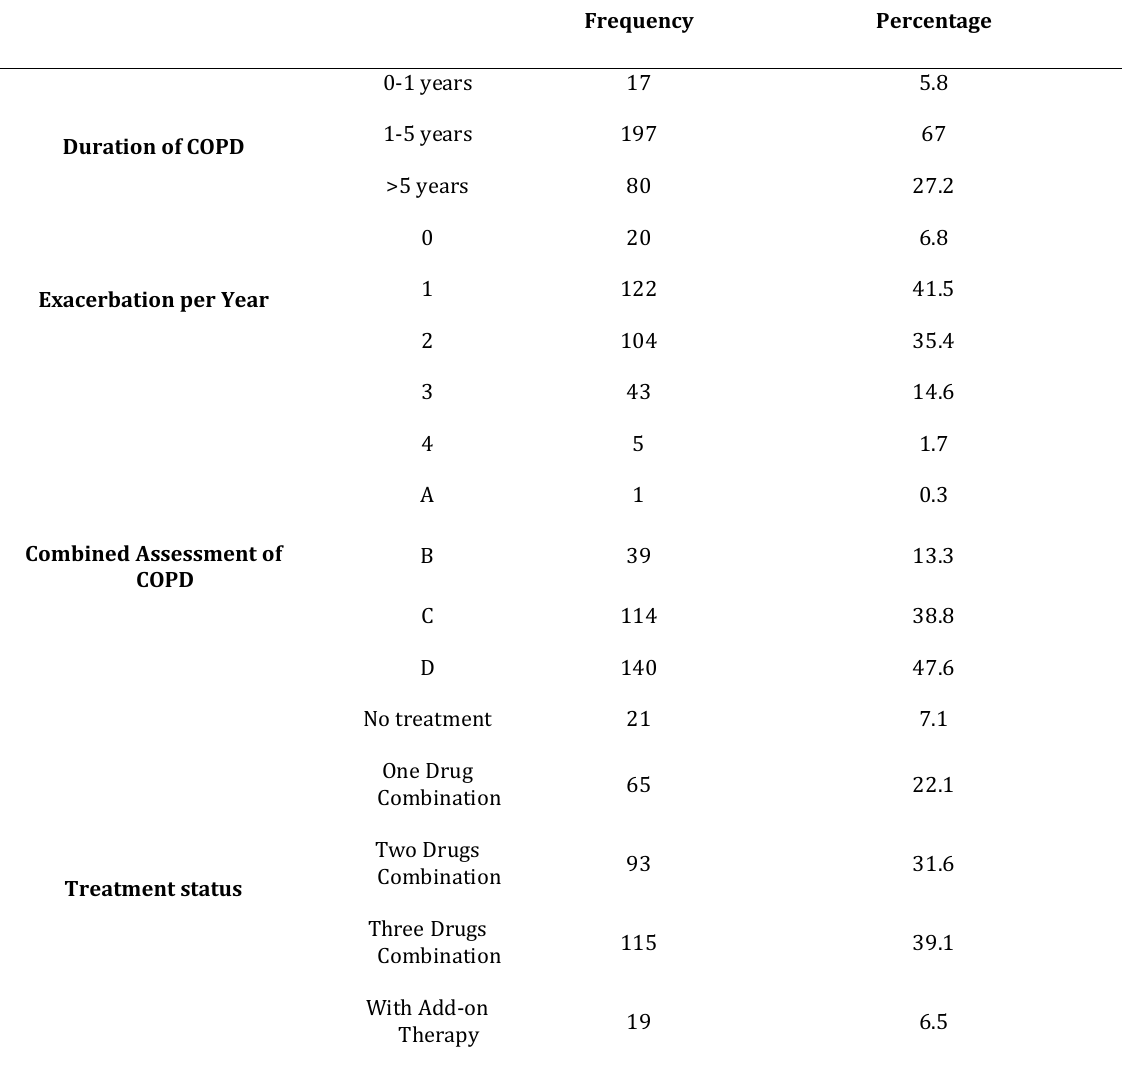
Table 2: Distribution of clinical pro=ile of COPD